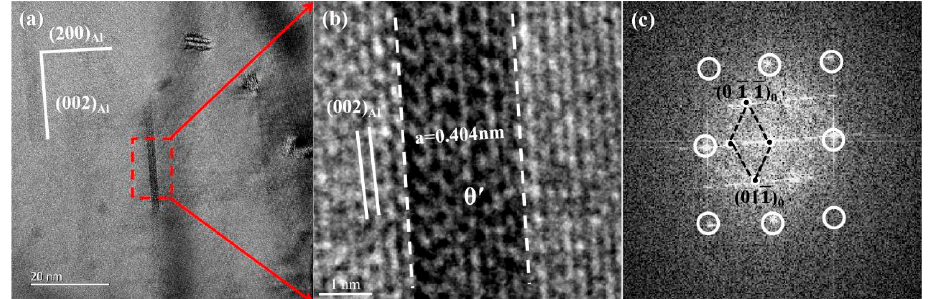
Figure 11. θ′ phase in A4 alloy after aging treatment, observed along the <010>Al axis: ( a ) TEM image, ( b ) HRTEM image, ( c ) corresponding FFT.